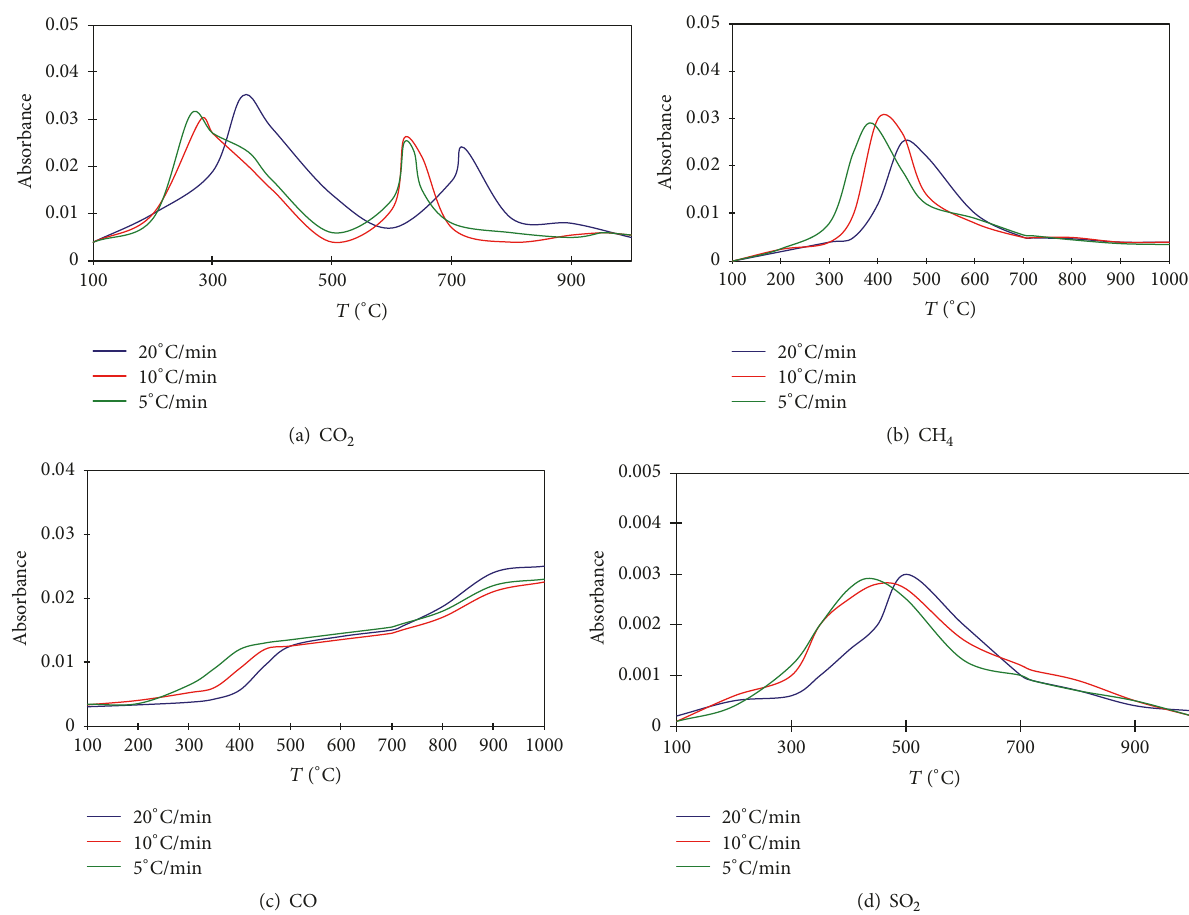
Figure 6: Evolution curves of the gaseous products with temperature: (a) CO 2 , (b) CH 4 , (c), CO (d), and SO 2 .